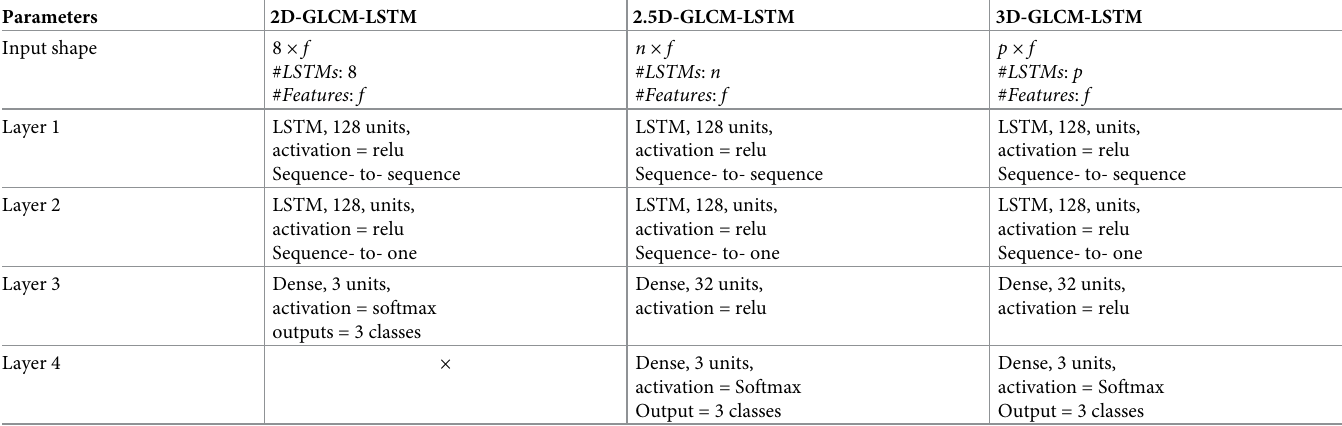
Table 1. The structure of the proposed LSTM-based fusion method. f refers to the number of elements in the extracted features.